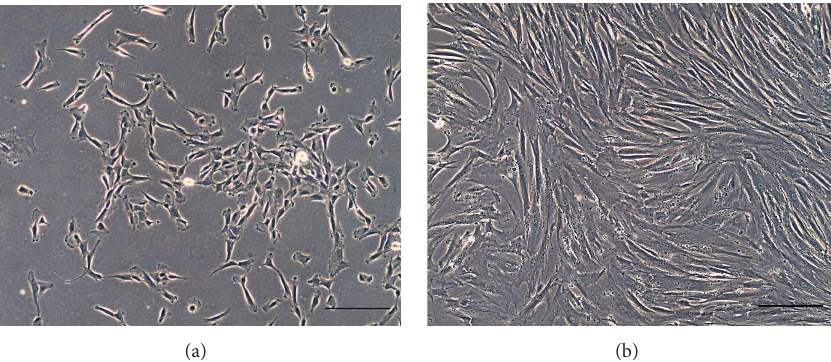
Figure 4: Small round cell osteosarcoma finite cell line. Observation in phase contrast of cell line of OSA3 after 15 days (a) and after 1 month (b) from mechanical disgregation.